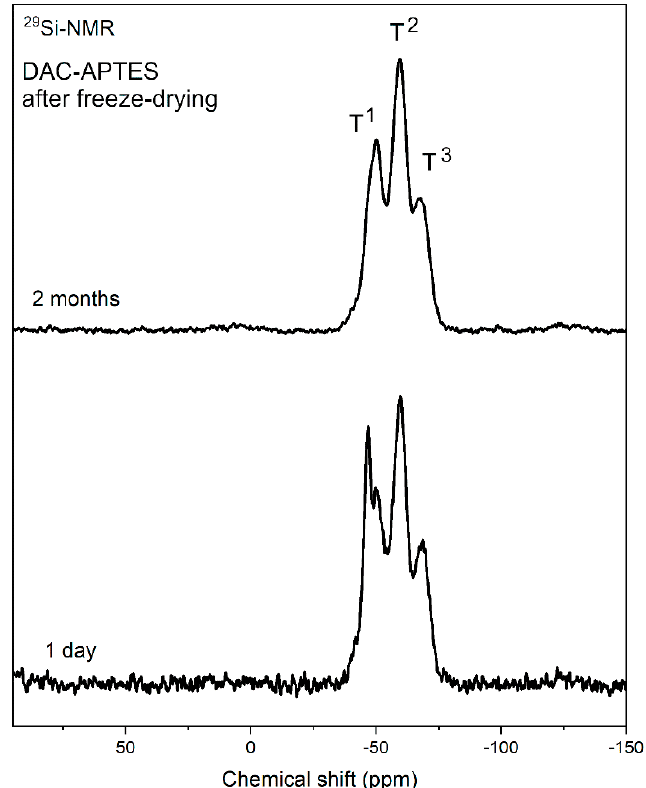
Figure 3. 29 Si CP/MAS NMR spectra of the DAC-APTES freeze-dried sample, after one day (lower spectrum) and after two months (upper spectrum), with the labels of the different condensed silica structures. The peak at –46.9 ppm in the one-day sample (lower spectrum) is attributable to residual, non-reacted starting material that was not removed by washing. The peak of the pure APTES (in the absence of the DAC matrix) appears at δ –45 ppm.